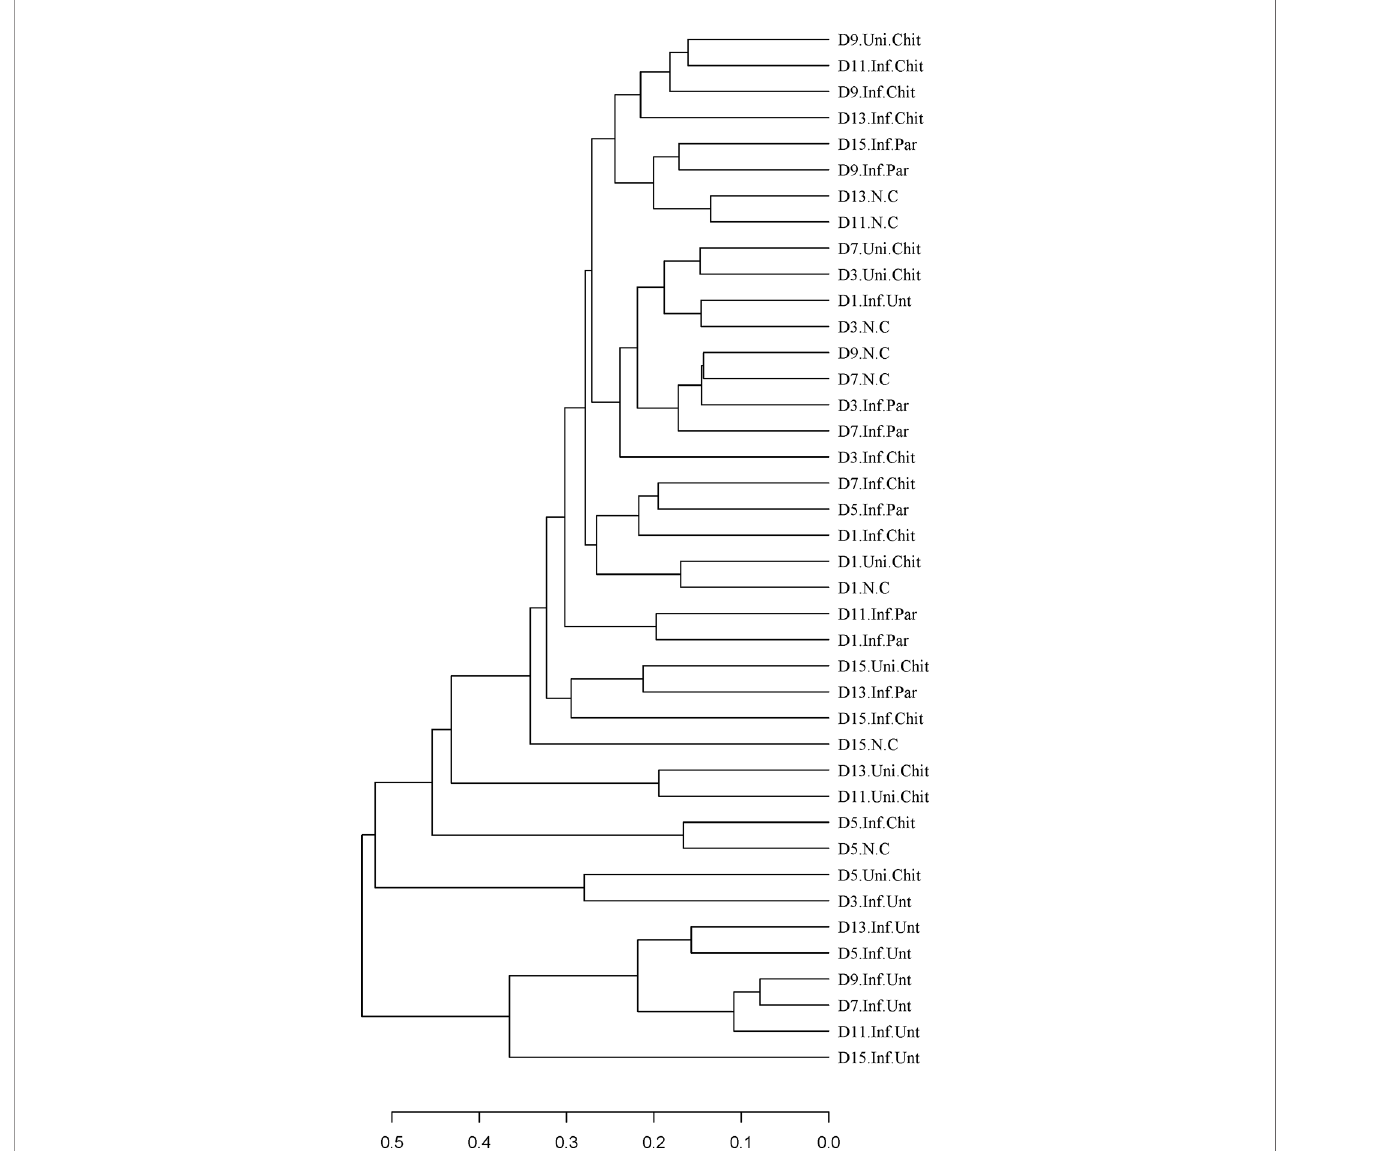
FIGURE 6 | Differences in beta diversity (UPGMA weighted UniFrac distance) between N.C, Inf.Unt, Inf.Par, Inf.Chit and Uni.Chit groups at different DPI. Note: The samples are clustered according to the similarity between each other. The shorter the branch length between samples, the more similar the two